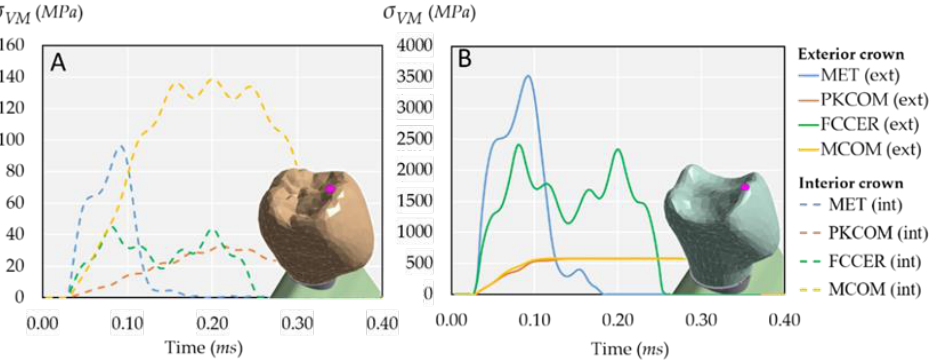
Figure 2. Von Mises stress at the selected nodes in both internal and external parts of the crown for the common materials: MET, PKCOM, FCCER, and MCOM. ( A ) Interior crown. ( B ) Exterior crown.